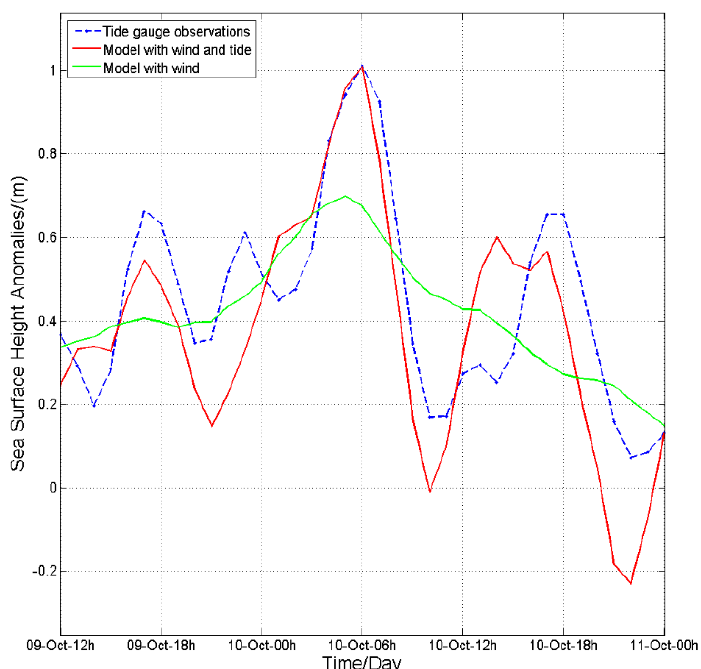
Figure 8. Non-tidal sea surface height anomalies at Xiamen from tide-gauge observations, from the model run forced by the National Center for Atmospheric (NCAR) wind modified by 1.3-times and from the model run forced by both the tide and the NACR wind modified by 1.3-times.